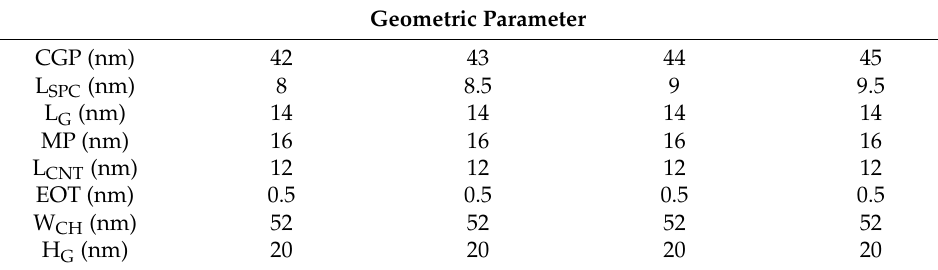
sion. Figure 2. BSIM-IMG model parameter extraction flow used in this work. Region (R EXT ) increases. This phenomenon is the same as the general phenomenon that appears in devices such as silicon FinFET [21]. However, although the I ON /I OFF ratio and subthreshold swing (SS) are noticeably changed in silicon FinFET, there is little